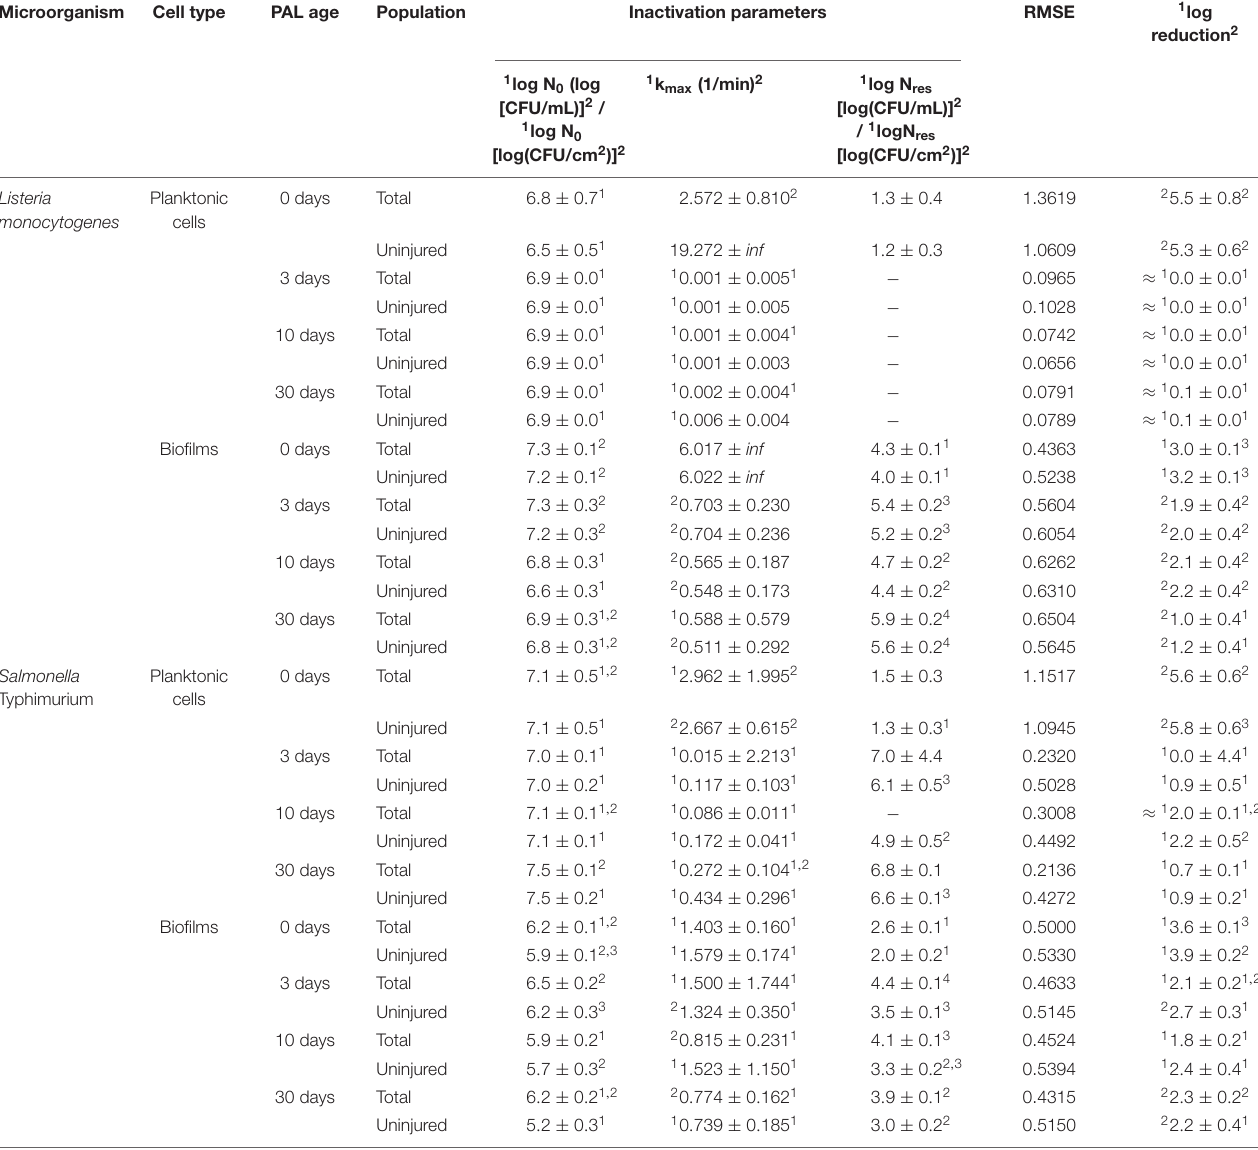
TABLE 4 | Inactivation parameters of Geeraerd et al. (2000) model for L. monocytogenes and S. Typhimurium planktonic cells and biofilms after treatment with plasma activated liquids of different ages. Microorganism Cell type PAL age